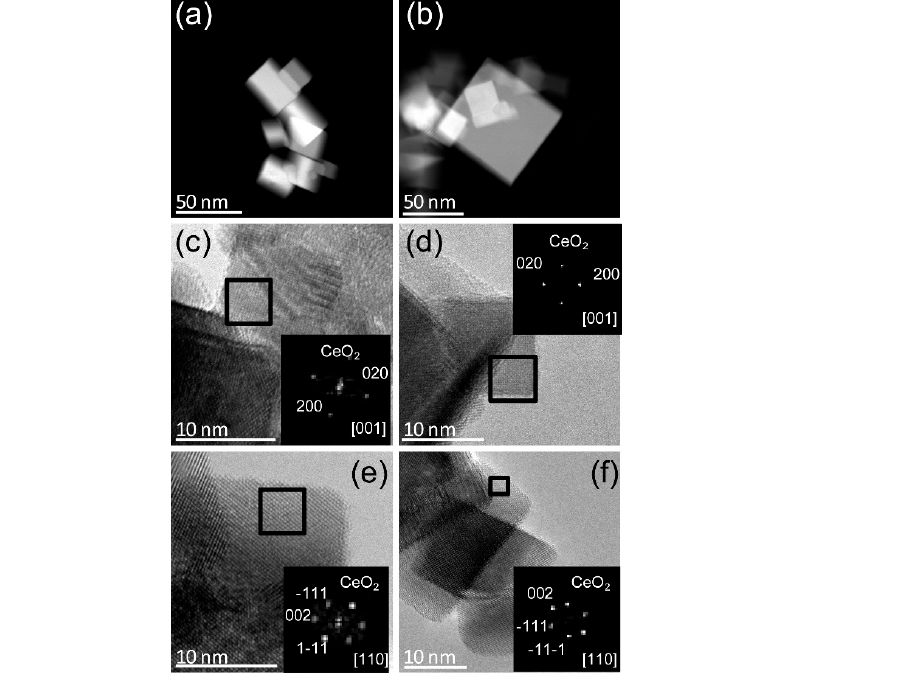
Figure 12. HAADF-STEM images of ( a ) CeO 2 nanocrystals and ( b ) 10% La-CeO 2 nanocrystals; HREM images of ( c , e ) CeO 2 nanocrystals and ( d ), ( f ) 10%La-CeO 2 nanocrystal samples in the [001] and [110] zone axis [104]. Reprinted with permission from Fernandez-Garcia, S.; Jiang, L.; Tinoco, M.; Hungria, A.B.; Han, J.; Blanco, G.; Calvino, J.J.; Chen, X. Enhanced Hydroxyl Radical Scavenging Activity by Doping Lanthanum in Ceria Nanocubes. J. Phys. Chem. C 2016 , 120 , 1891–1901. Copyright (2016) American Chemical Society.